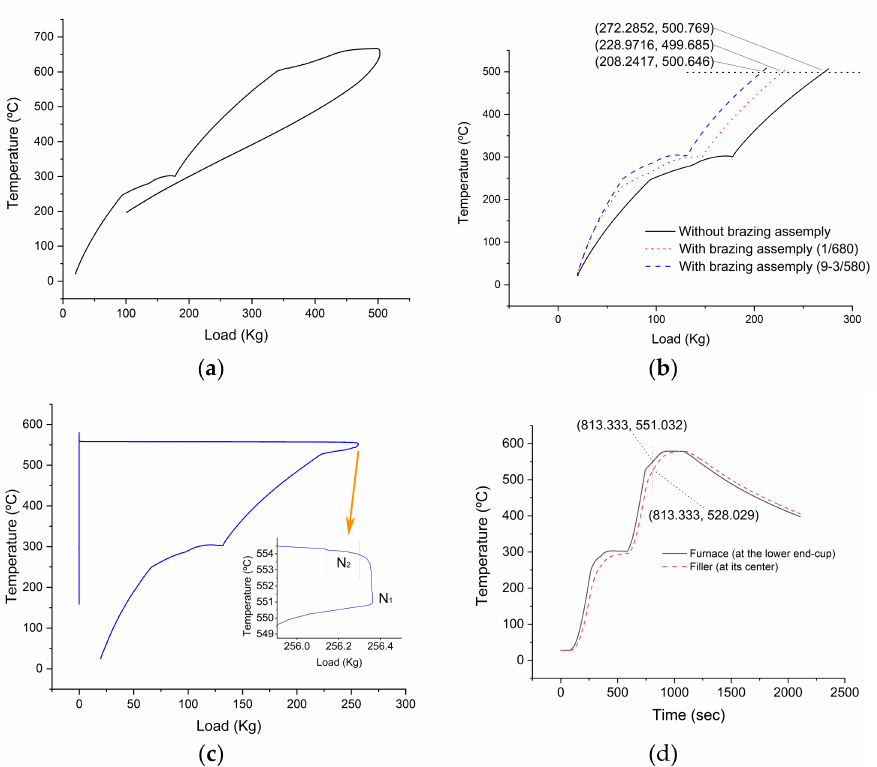
Figure 11. ( a ) A load temperature cycle/3 min holding at 300 ◦ C, 3 min holding at 665 ◦ C/without brazing assembly, the curve is showing the expansion of the ceramic pivots ended by the titanium cups under the effect of temperature, the initial load was set to 20 kg; ( b ) Comparison of load temperature cycles until around 500 ◦ C between two brazing processes and the case in (a), the difference in the load increase rates is an indication of the filler compliance under the load and the roughness of the base metal; ( c ) Load–temperature cycle for brazing process 9-3/580, the load was removed at N 2 after the filler passed the point N 1 ; ( d ) Actual temperature-time cycles (thermal cycles) of the furnace and the filler Al-9Si-3Cu without USV. The filler temperature in Figure 11d was measured using type K thermocouple, Ø 0.25 mm, of special error range (0.4%).